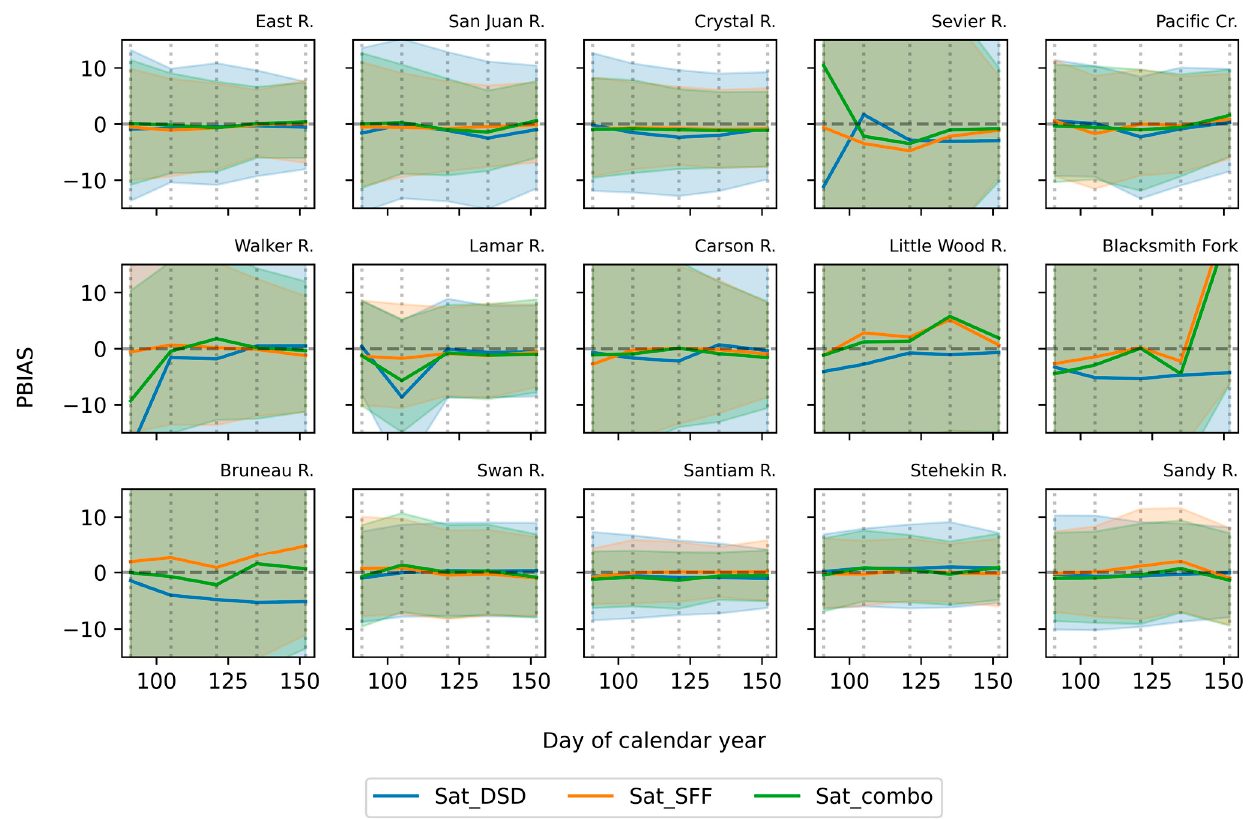
Figure 4. The median percent bias, PBIAS, statistics for three different satellite-based water supply forecasts with interquartile range (25/75 percentiles) shaded, for all 15 study basins. Vertical dotted lines denote the days chosen for forecasting—1 April, 15 April, 1 May, 15 May, and 1 June.